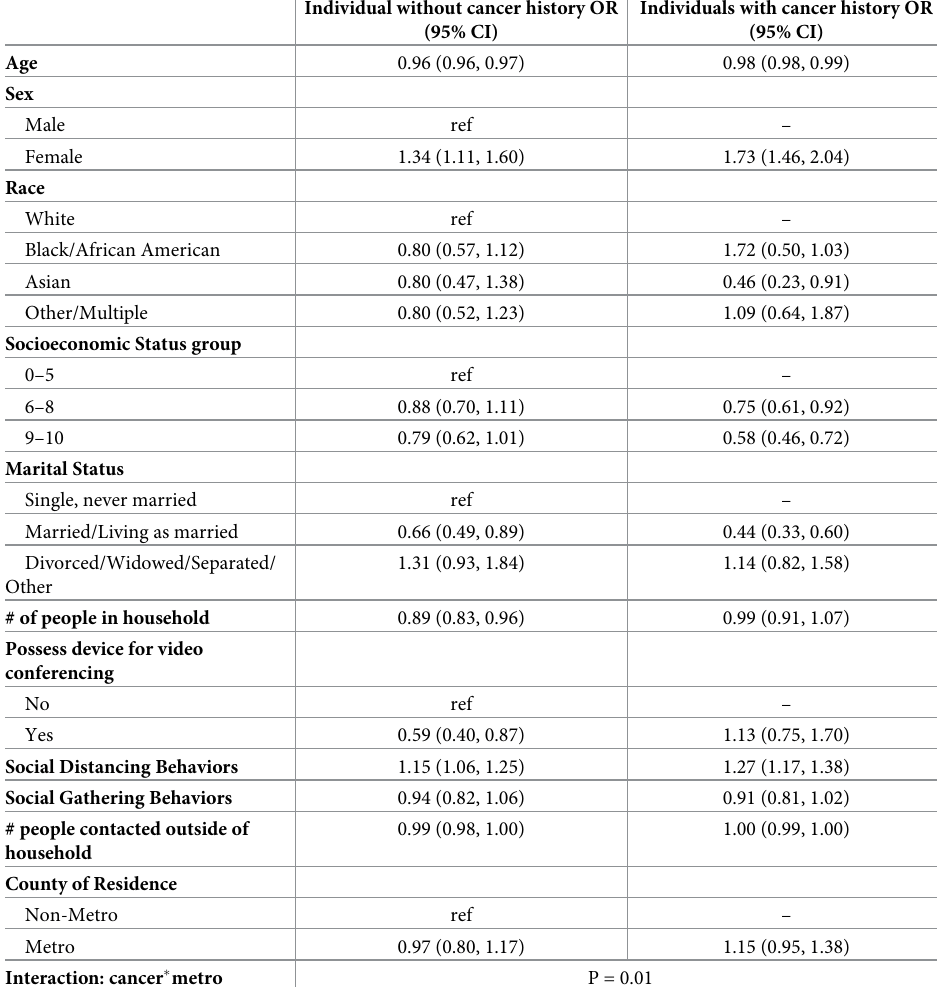
Table 4. Associations between metro residency, social distancing measures, and loneliness by cancer